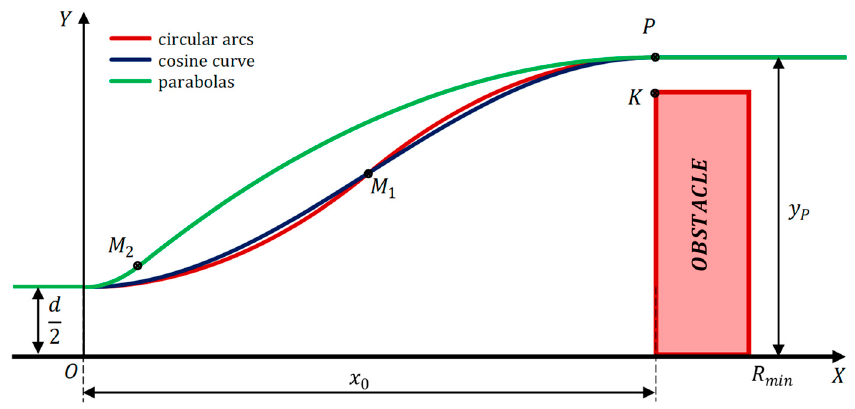
Figure 12. Shapes of trajectory 𝑦 (cid:3014) (𝑥) , obtained from the three trajectory calculation methods.